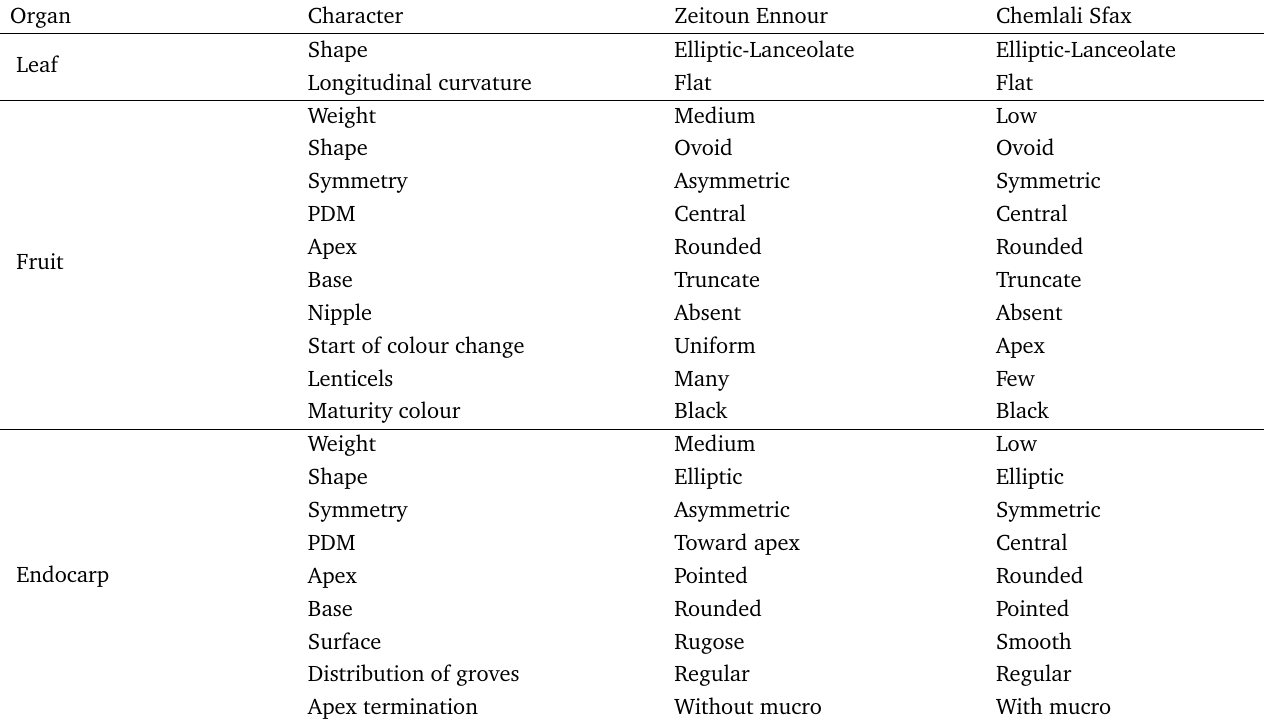
Table 1. Description of the main morphological characters of olive cultivar ‘Zeitoun Ennour’ compared with the control ‘Chemlali Sfax’. PDM : Position of Maximum transverse Diameter Organ